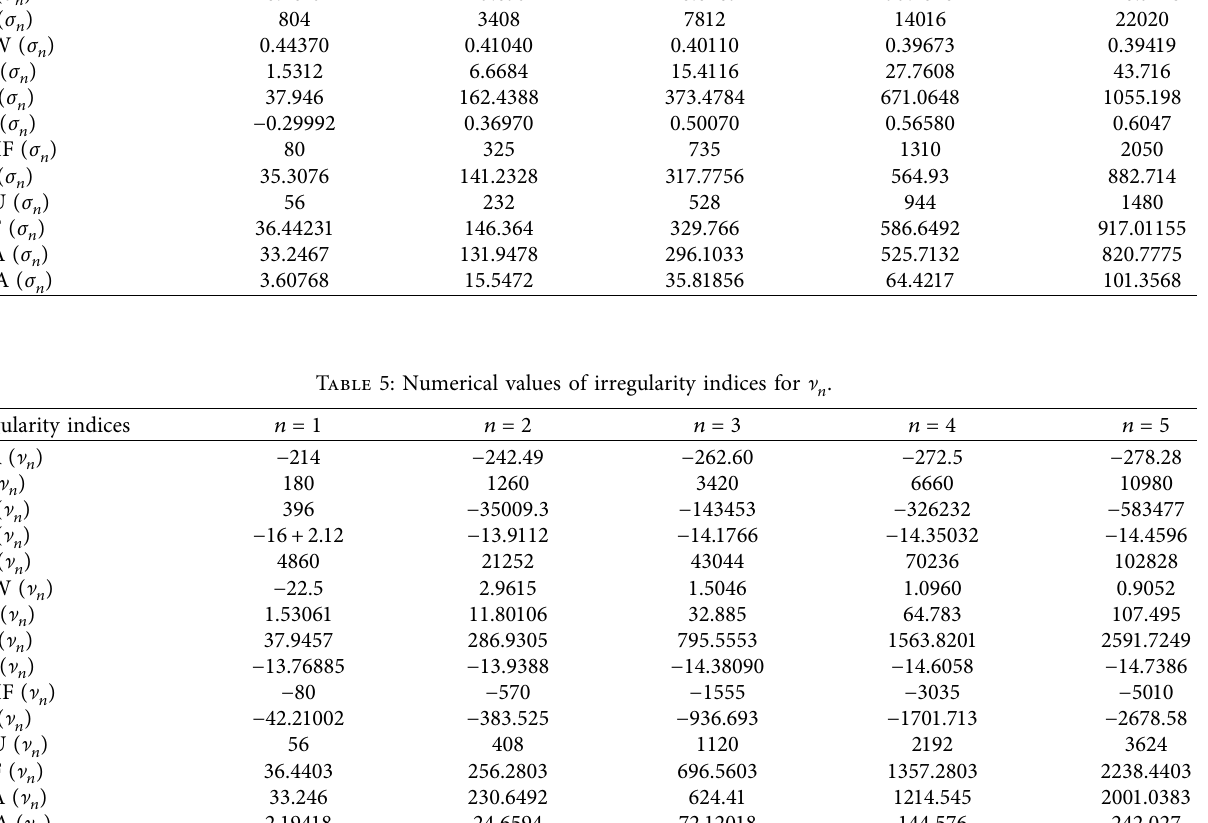
Table 6: Numerical values of irregularity indices for μ